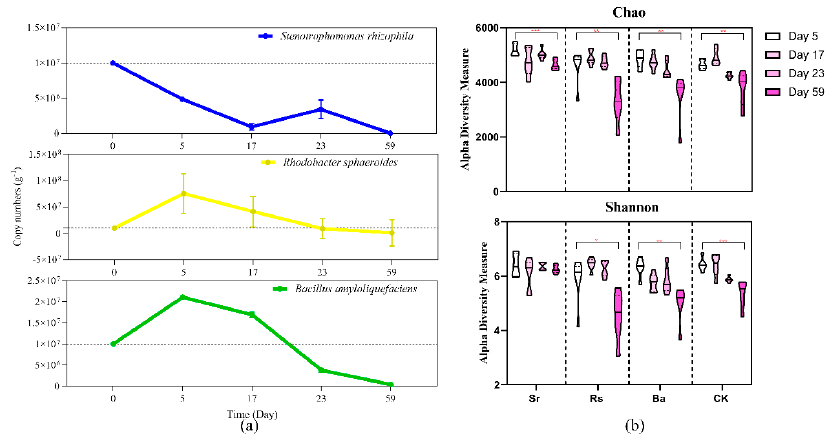
Figure 1. ( a ) Quantitative curve trends of PGPR strains from day 5 to day 59, the peripheral curve represents the error (SD) line; ( b ) Chao and Shannon index of alpha diversity for four treatments during four stages. Significant levels: ns; * p < 0.05; ** p < 0.01, *** p < 0.001.